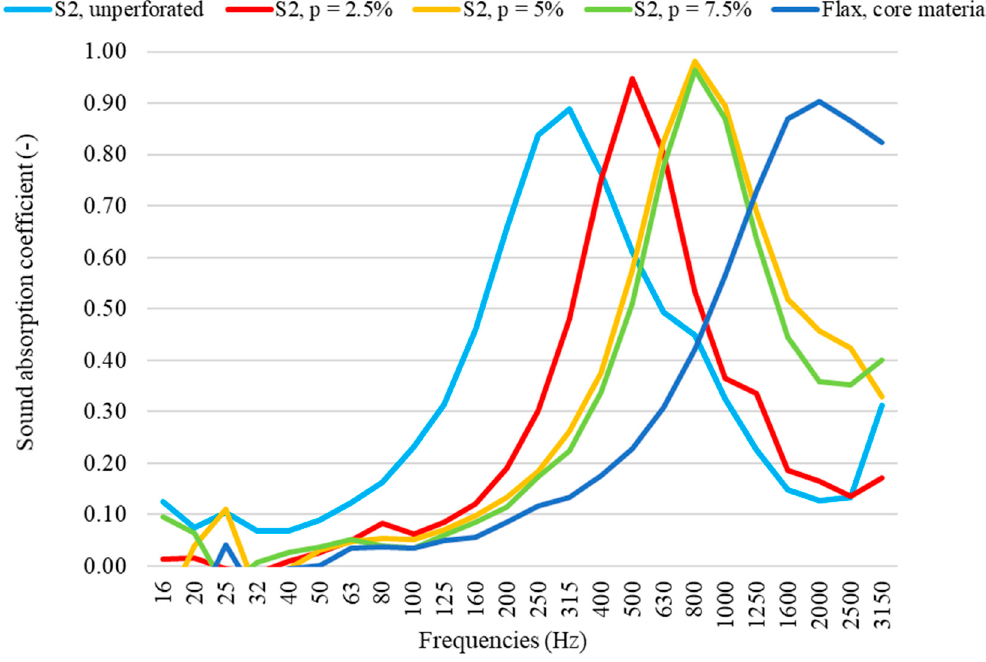
Figure 8. Sound absorption coefficient variation with different perforation percentages (sample S 2 ).